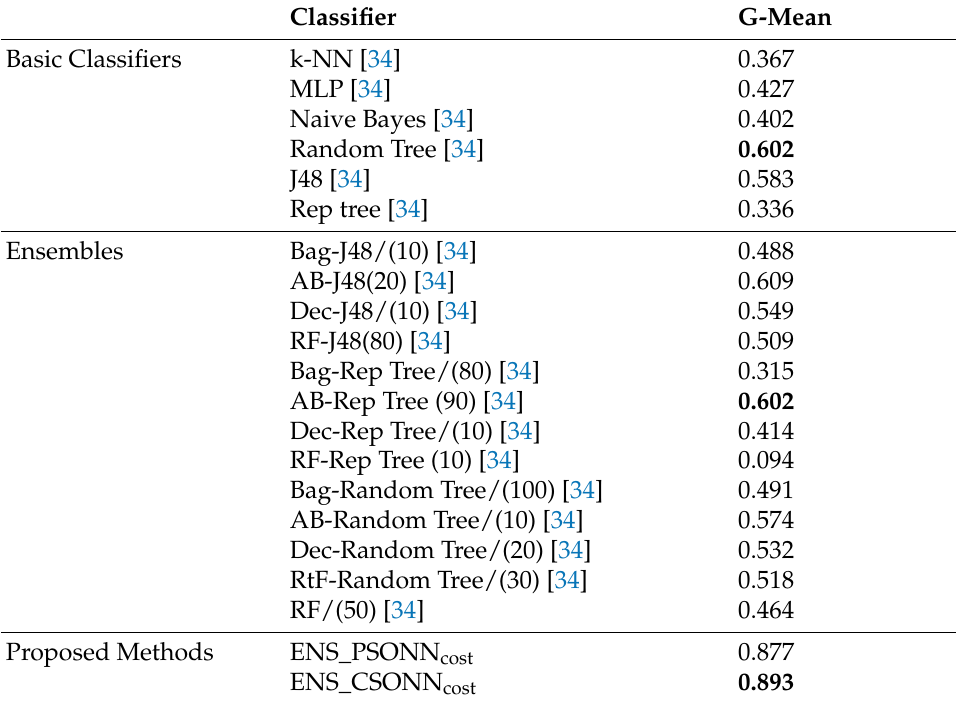
Table 15. The results for the g-mean scores of the standard classifiers that were used in the related work compared to those of the two methods that are proposed in this work using the dataset of Spanish companies. The best g-mean result per classification approach is marked in